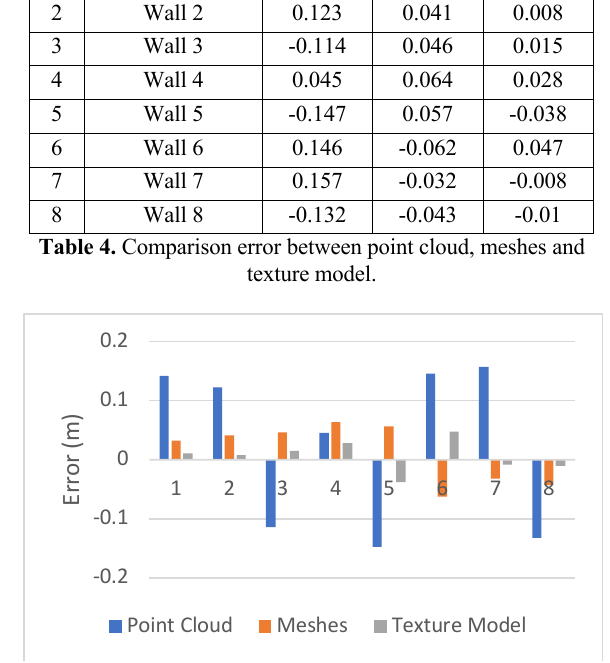
Figure 5. Pattern error between point cloud, meshes and texture